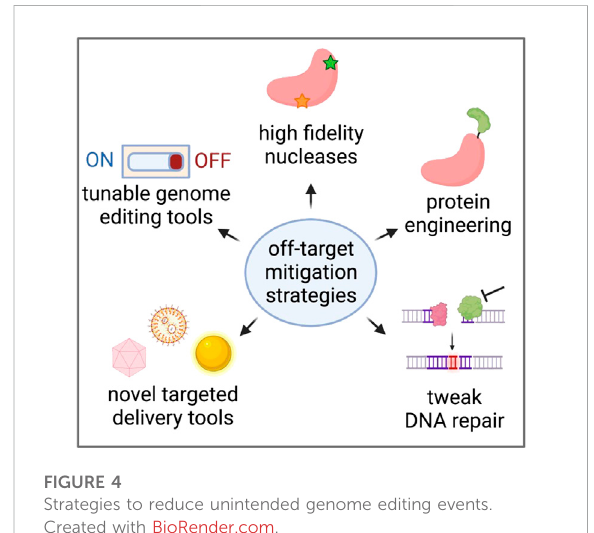
FIGURE 4 Strategies to reduce unintended genome editing events. Created with